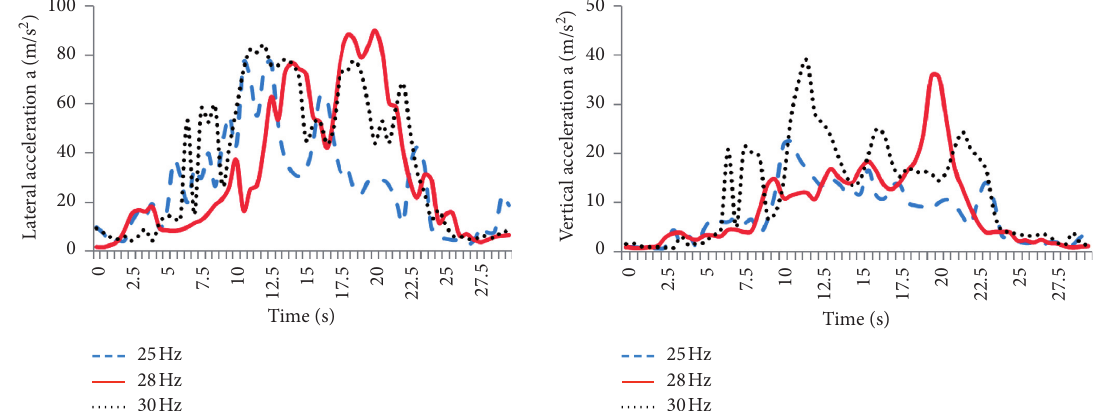
Figure 9: The envelope of acceleration of sleeper under different vibration